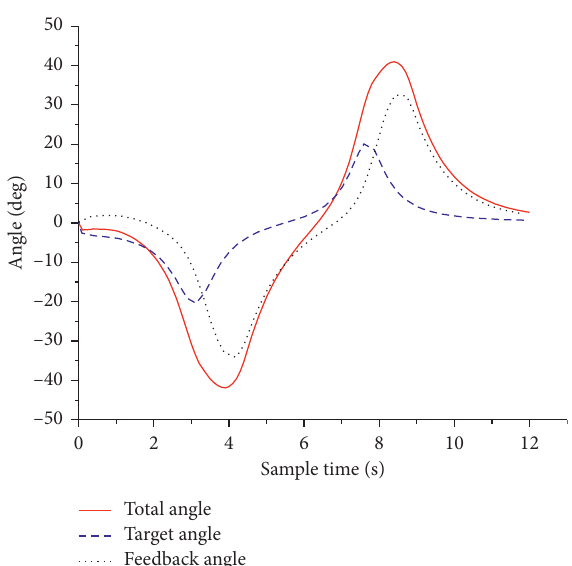
Figure 13: Simulation diagram of curve tracking steering angle.